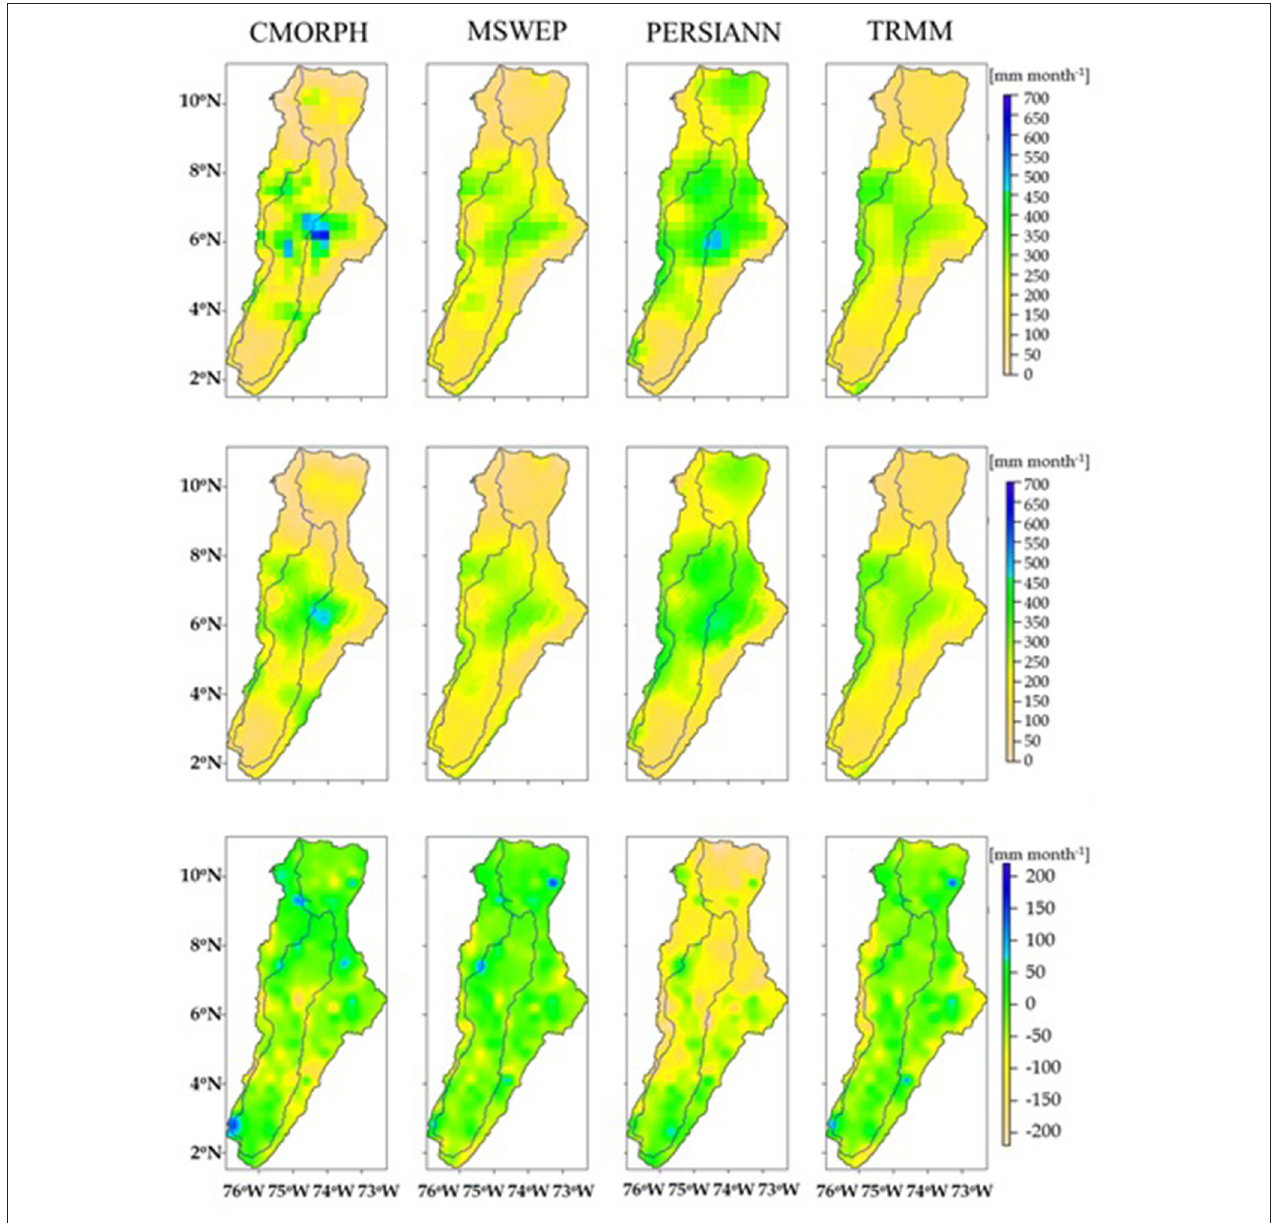
FIGURE 5 | Spatial distribution of CMORPH, MSWEP, PERSIANN, and TRMM precipitation datasets at 25km ( P , first row) and 1km ( PD , second row) and spatial distribution of residuals at 1km ( 1 , third row) for April 2000.